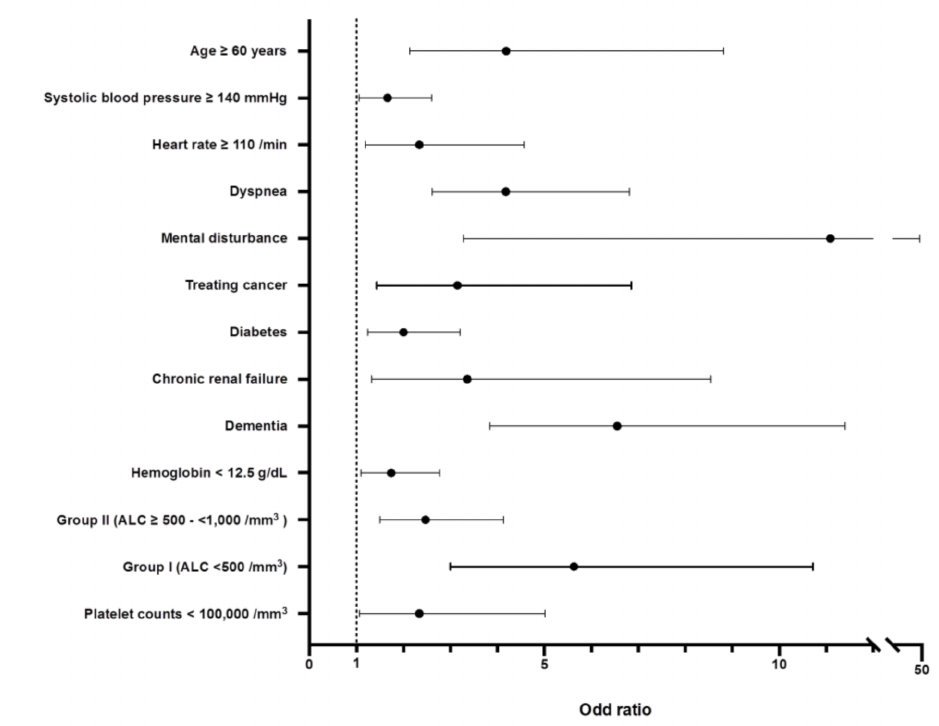
Figure 4. Odds ratios of identified parameters associated with the morality of COVID-19. Abbrevia- tion: ALC, absolute lymphocyte